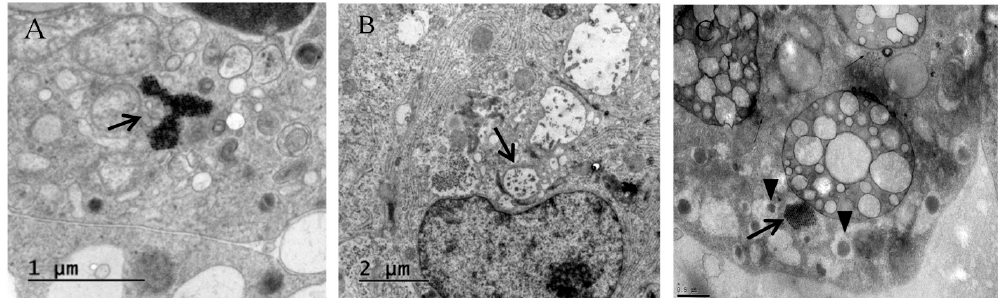
Figure 4. Electron microscopy of exocrine and endocrine cells infected with E6/11. ( A ) Virus particles (arrow) arranged in arrays in the cytoplasm of acinar cells, scale bar: 1 μ m; ( B ) Portion of acinus showing degraded cytoplasm, membrane vesicles and vacuoles (arrow), scale bar: 2 μ m; ( C ) Beta cells from islets infected with E6 containing virus particles arranged in a cluster (arrow) in close proximity to insulin granules (arrowhead), scale bar: 0.5 μ m.